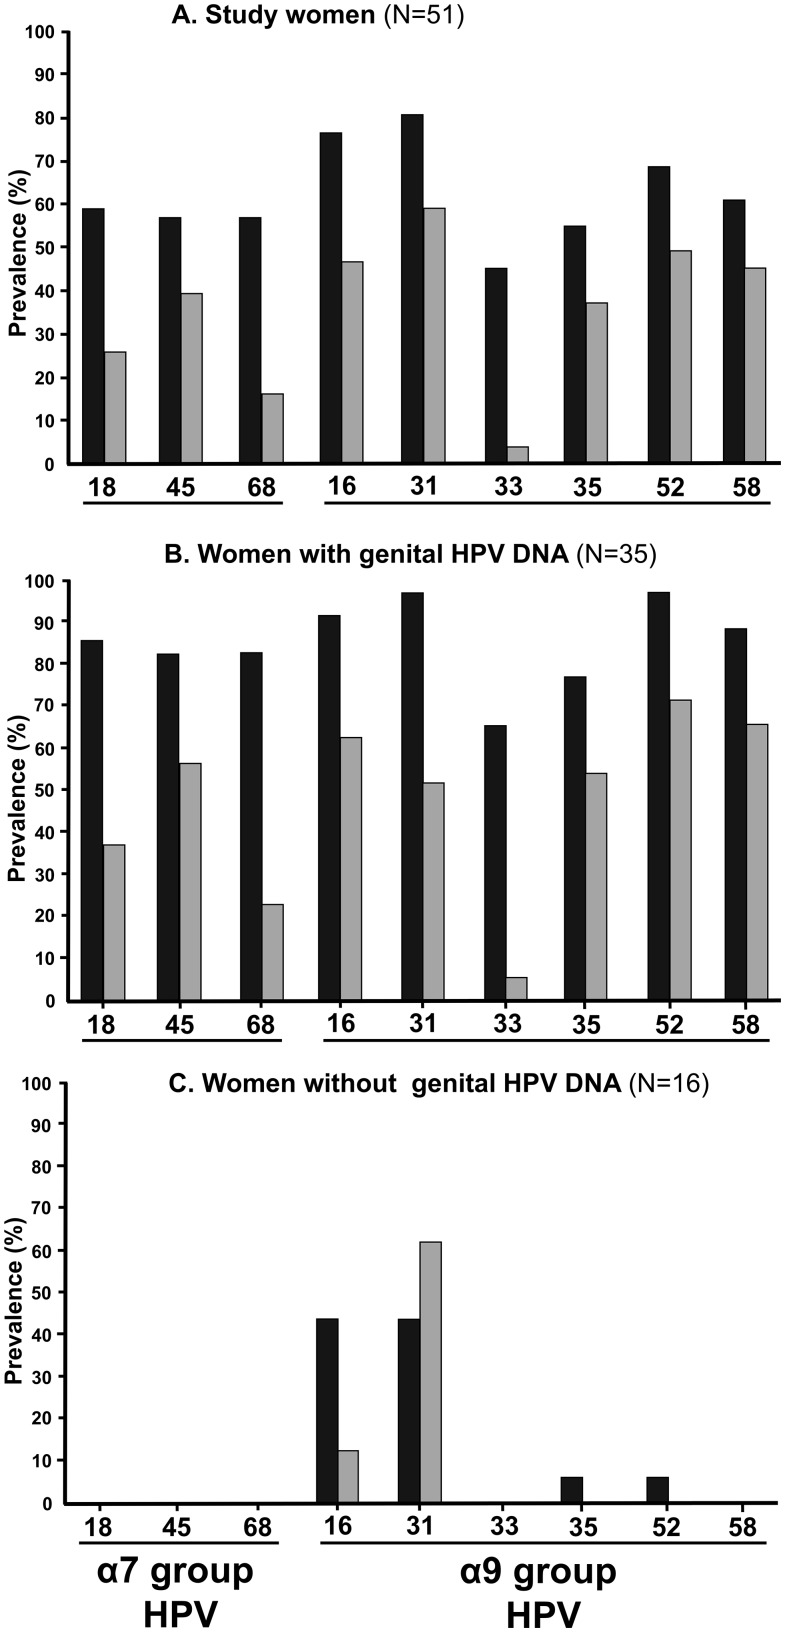
Prevalences of IgG reactivities to α7/α9 HPV types in paired serum (black boxes) and cervicovaginal secretions (grey boxes) according the presence of genital HPV DNA.A. Whole study population of first-generation immigrate African women (N = 51); B. Women with positive HPV DNA detection in their genital tract (group I; N = 35); C. Women with negative cervicovaginal HPV DNA detection (group II; N = 16).